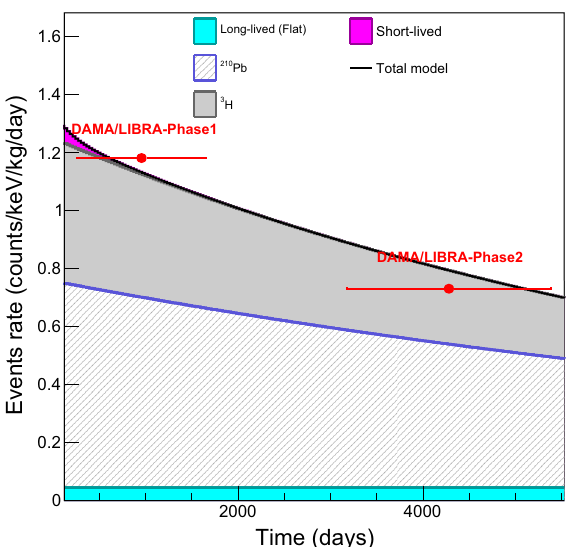
Figure 6. Background model for DAMA/LIBRA using the COSINE-100 background compositions. Background compositions of the COSINE-100’s crystal (crystal 6) in the 2–6 keV single-hit regions are scaled to have 1.3 counts/keV/kg/day at the beginning of DAMA/LIBRA-phase1. Here dominant background 210 3 contributions are Pb (half-life of 8140 days) and H (half-life of 4494 days). The total model (black solid line) is compared with the averaged rate in the 2–6 keV region from the initial 4 years of the DAMA/LIBRA-phase1 26 and 6 years of the DAMA/LIBRA-phase2 16 . Due to the decays of the time-dependent backgrounds, this model presents a decreasing rate as a function of time. This model describes the rate of decrease obtained from the DAMA/LIBRA-phase1 to DAMA/LIBRA-phase2 denoted in the plot.